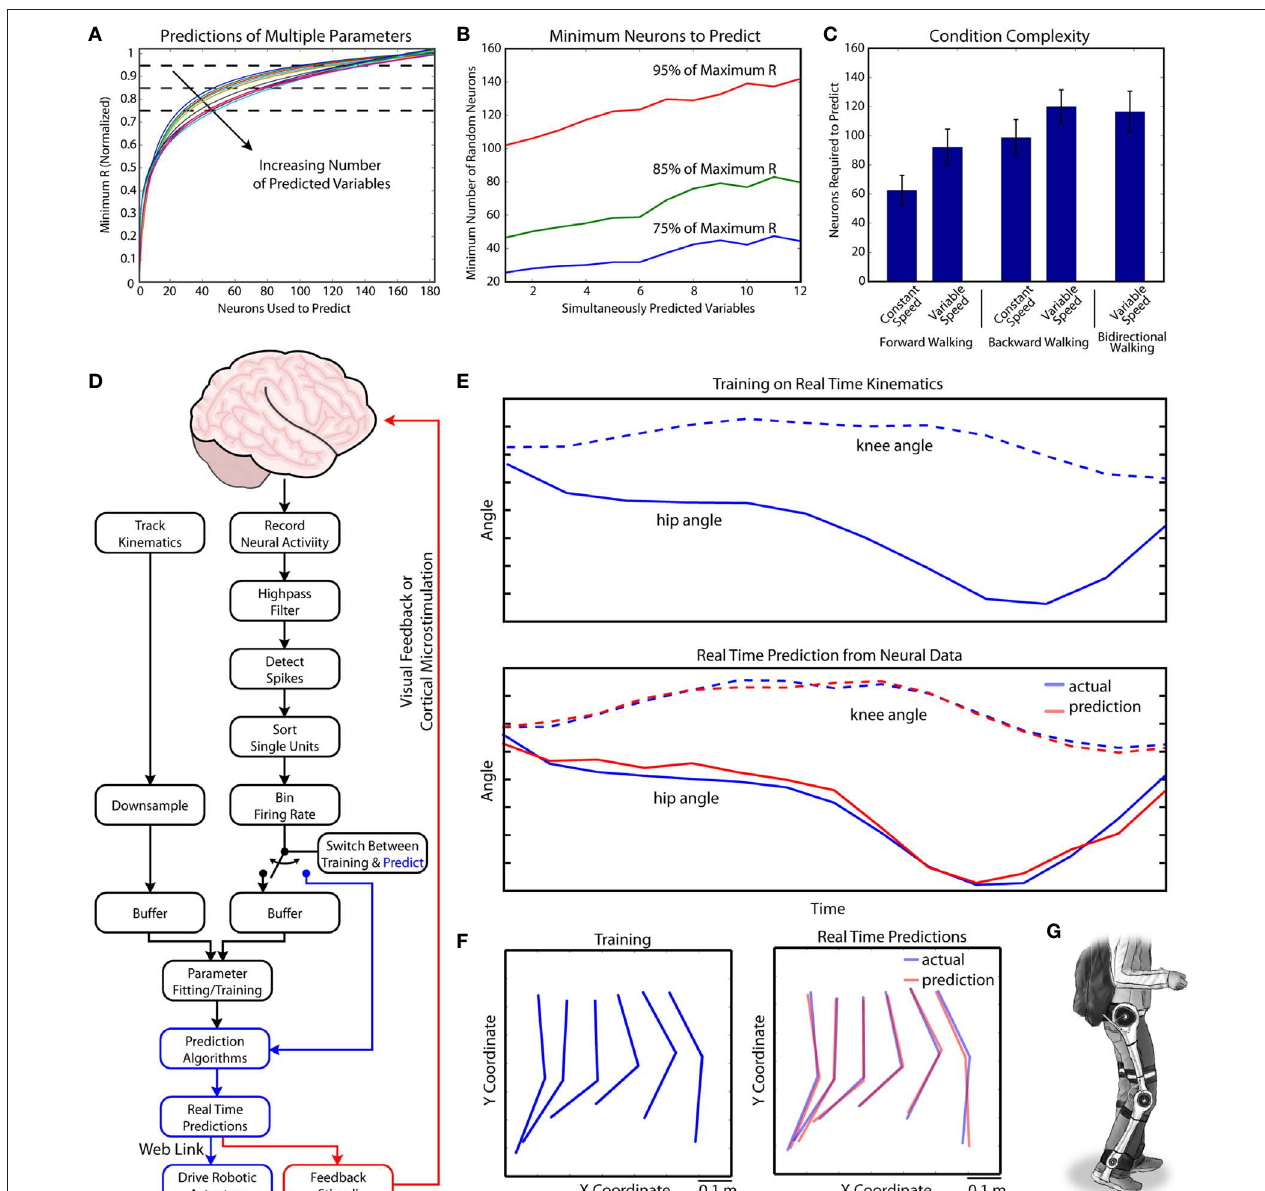
FIGURE 8 | Simultaneous extraction of multiple parameters and real-time parameter extraction. (A) Neuronal dropping curves for extracting multiple parameters of walking. Each point on the curve represents the number of neurons needed to achieve a certain minimum level of prediction accuracy for each parameter (expressed as R normalized by the maximum value). The curves were fi tted to the data for random groups of neurons used to predict random combinations of variables. This analysis revealed a slower rise for the multiple parameter dropping curves, indicating that larger neuronal populations were needed to predict multiple parameters simultaneously. (B) Number of neurons needed to attain a certain level of prediction accuracy (75%, 85% and 95% of maximum R) as the function of the number of simultaneously predicted variables. The curves were calculated from the neuron dropping curves shown in (A) These graphs show that the number of neurons needed for accurate prediction increased with the number of simultaneously extracted parameters of walking. (C) A comparison of the necessary number of neurons needed to accurately predict parameters in a variety of walking modes of different